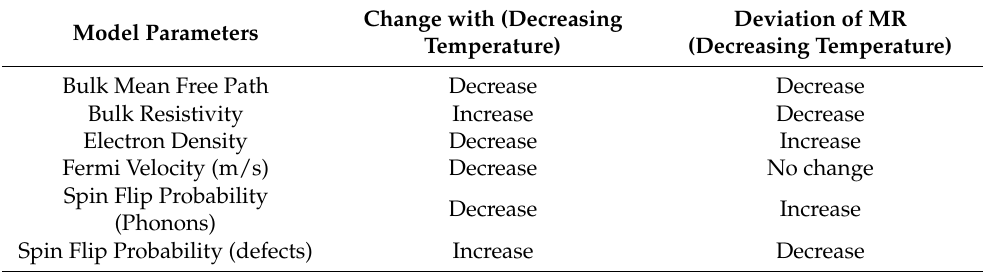
Table 2. Model Parameters Deviation for Fe 3 O 4 with temperature and its relation with change of TMR, provided other Parameters donot change their equilibrium values shown in Table 1.